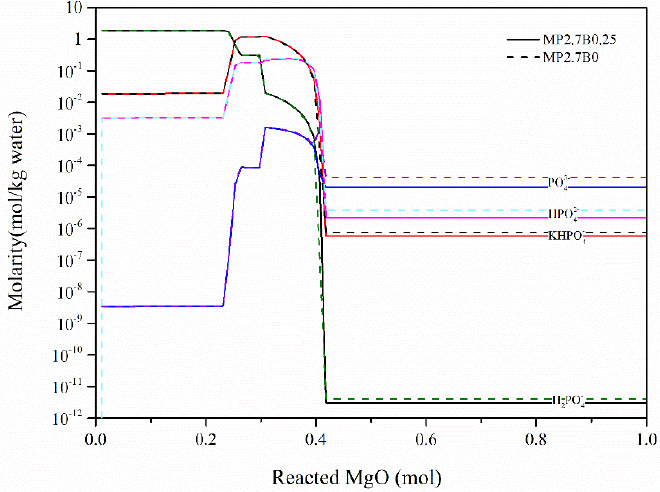
Figure 6. Comparison of the molarity of MP2.7B0.25 and MP2.7B0 during the hydration.